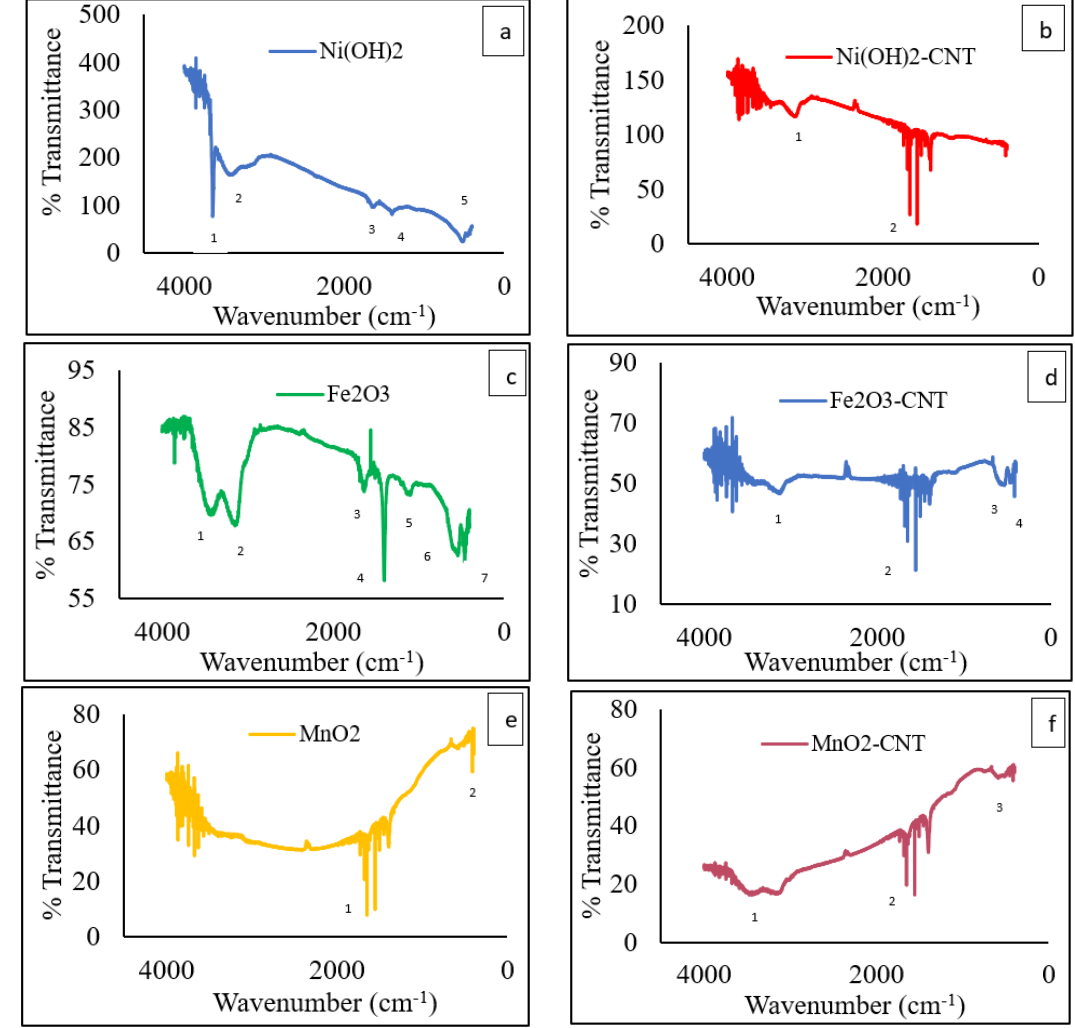
Figure 4. FTIR Analysis of ( a ) Ni(OH) 2 ; ( b ) Ni(OH) 2 _CNT; ( c ) Fe 2 O 3 ; ( d ) Fe 2 O 3 _CNT; ( e ) MnO 2 ; and ( f ) MnO2_CNT.